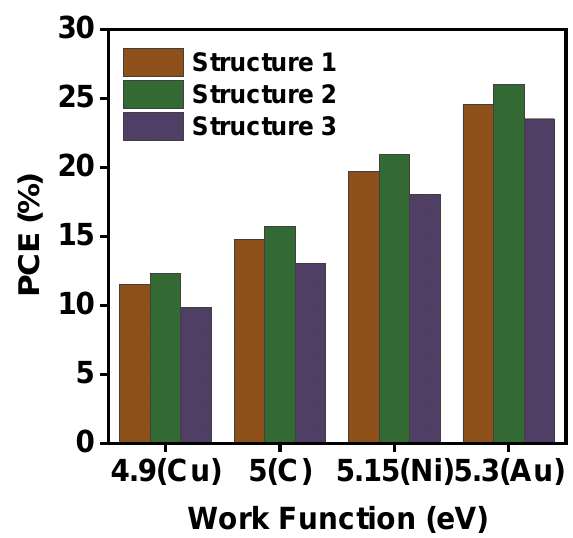
Figure 6. Solar cell efficiency for different back contact metals .